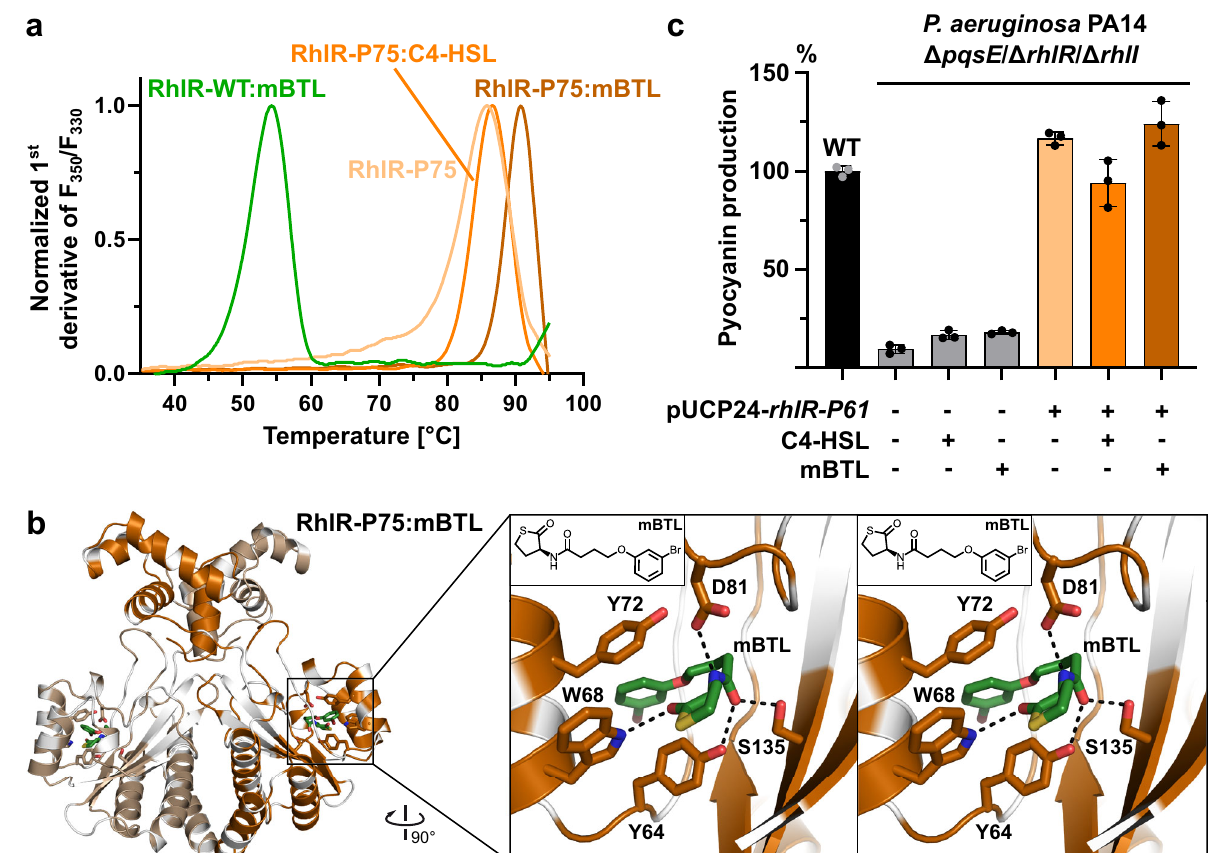
c Stability-optimized RhlR-P61 (RhlR-P75 with WT-DBD) stimulates pyocyanin productionina P.aeruginosa PA14 Δ rhlR / rhlI / pqsE triple mutantwithout requiring C4-HSL or mBTL.Meanvalues with error bars indicating the standard deviation of threeindependentmeasurementsareshown.SourcedataareprovidedasaSource Data fi